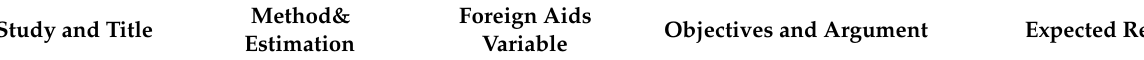
Table A11. Lists of the Literature Concerning Allocated Aids to Specific